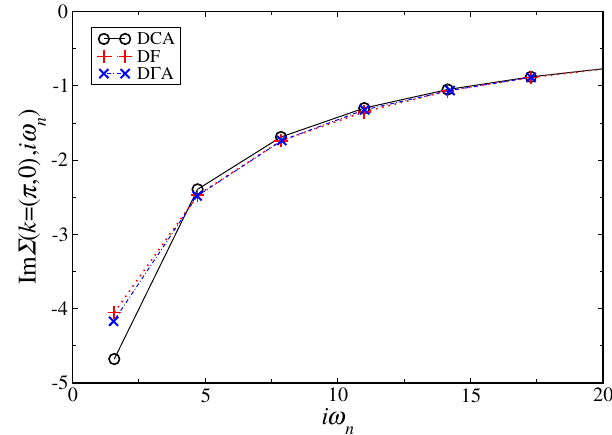
FIG. 17. Comparison of the frequency dependence of the imaginary part of the self-energy, Im Σ ð k; i ω n Þ , at fixed k ¼ ð π ; 0 Þ obtained from DF (red) compared to 72-site DCA calculations (black) plotted for n ¼ 1 . 0 , U=t ¼ 8 , T=t ¼ 0 . 5 . i ω at loc ð n Þ Also shown are results from the dynamical vertex approximation D Γ A (blue)